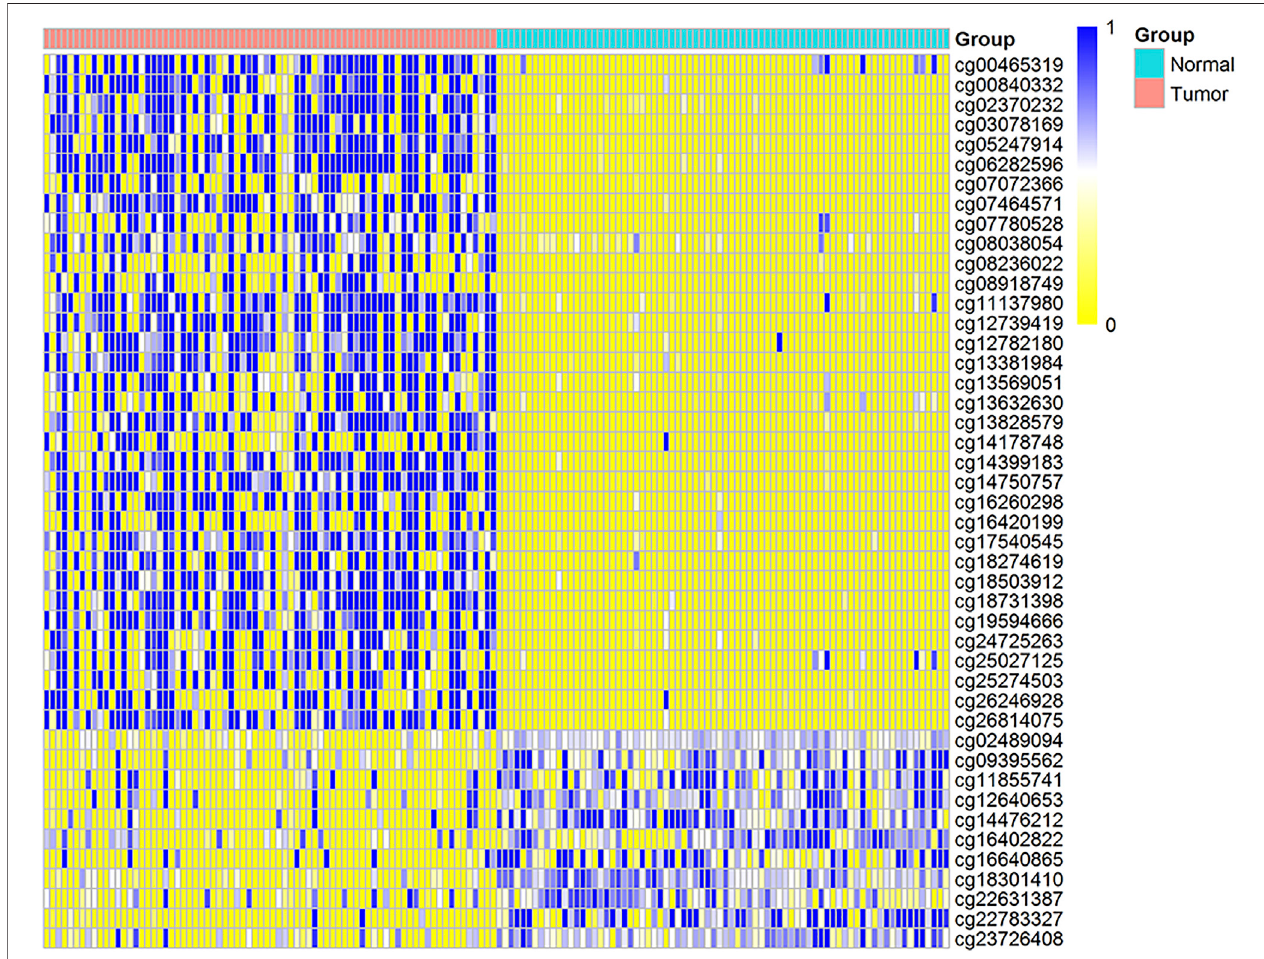
FIGURE 5 | The DNA methylation distribution map of probes for 17 key gene, the distribution heat map of the DNA methylation value of 45 CpG sites in 150 matchedcancersandparacanceroussamples.TherowrepresentstheDNAmethylationvalueofeachCpGsite,andthecolumnrepresentseachsample.Blueindicates the trend of DNA methylation value close to 1, and yellow indicates that the DNA methylation value is close to 0.